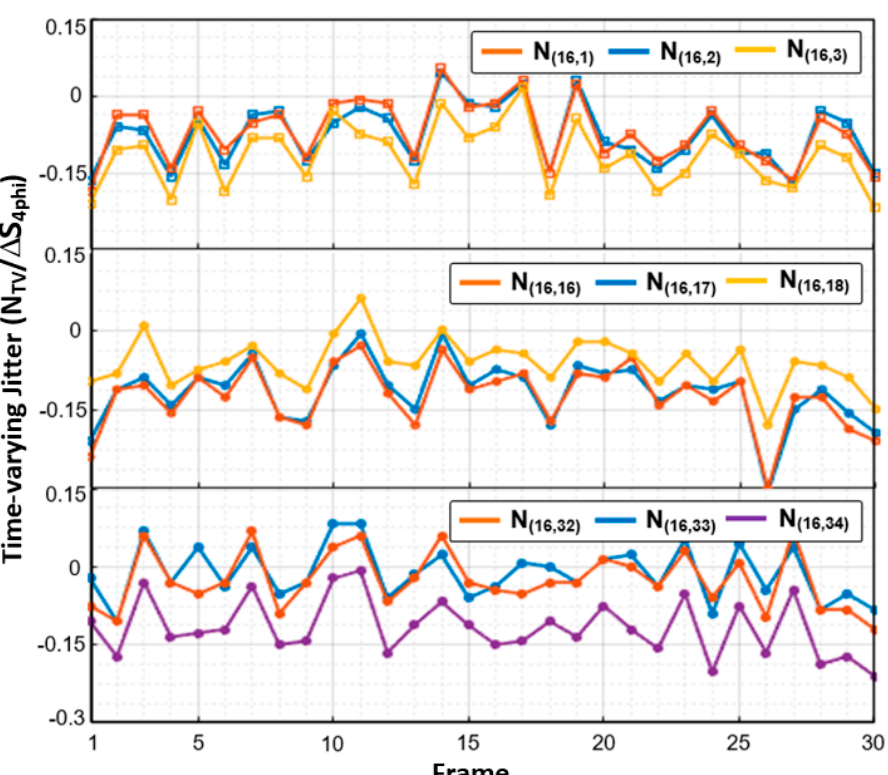
Figure 3. Measured time-varying jitter values at the leftmost, middle, and rightmost area of the TSP for 16 × 34 flexible AMOLED display.